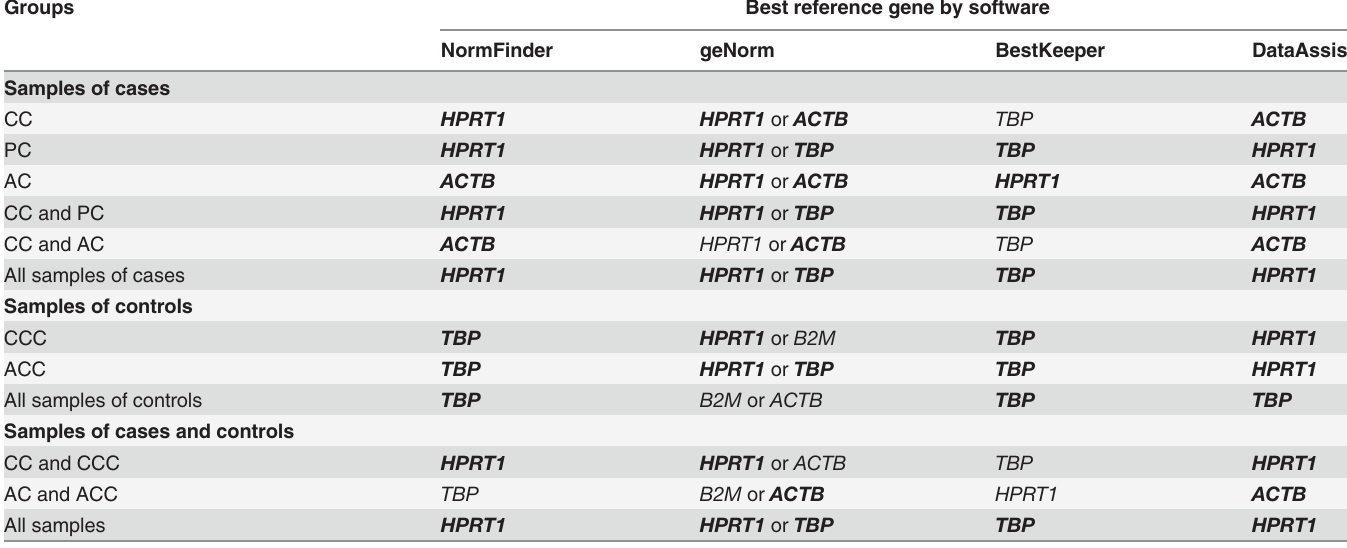
Table 3. Best reference gene for each group of